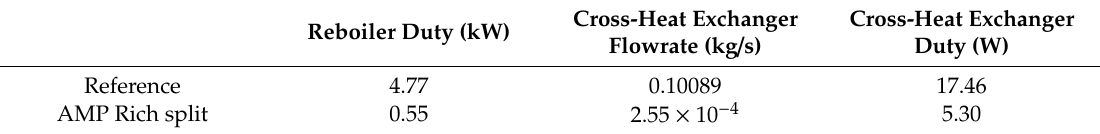
Table 7. Results for rich split and Table 7: Results for rich split and intercooling